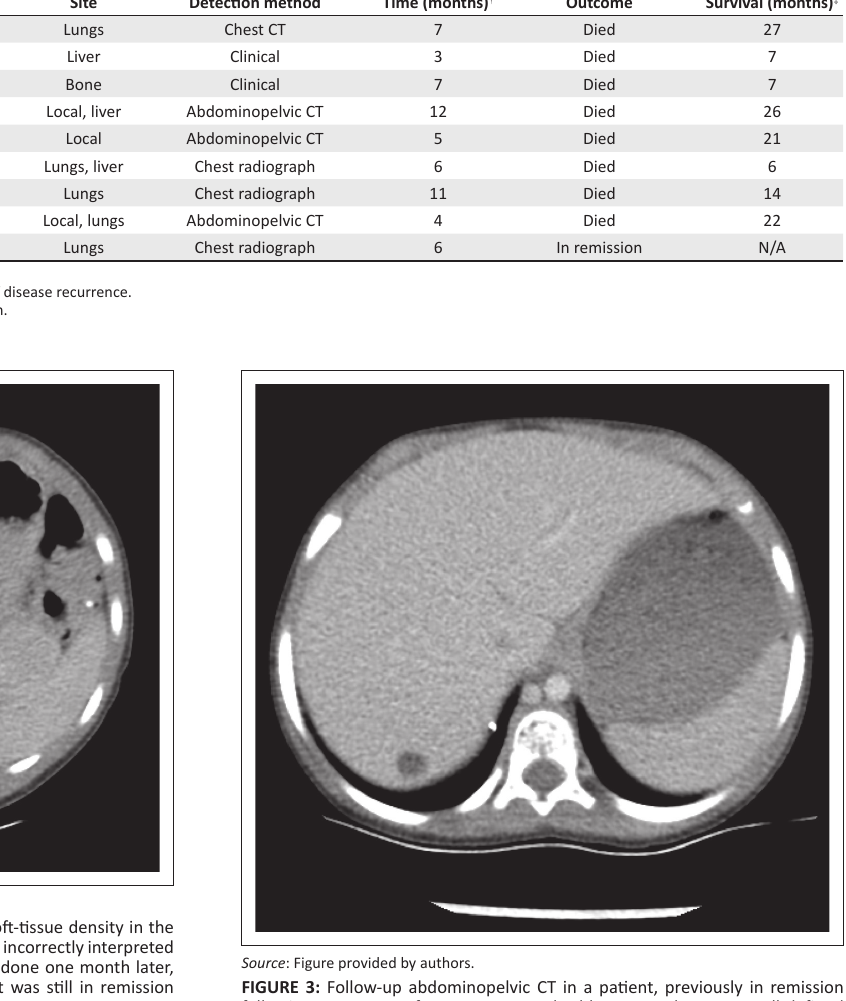
TABLE 3: Characteristics and outcomes of cases ( n = 9) with recurrence of Wilms tumour.